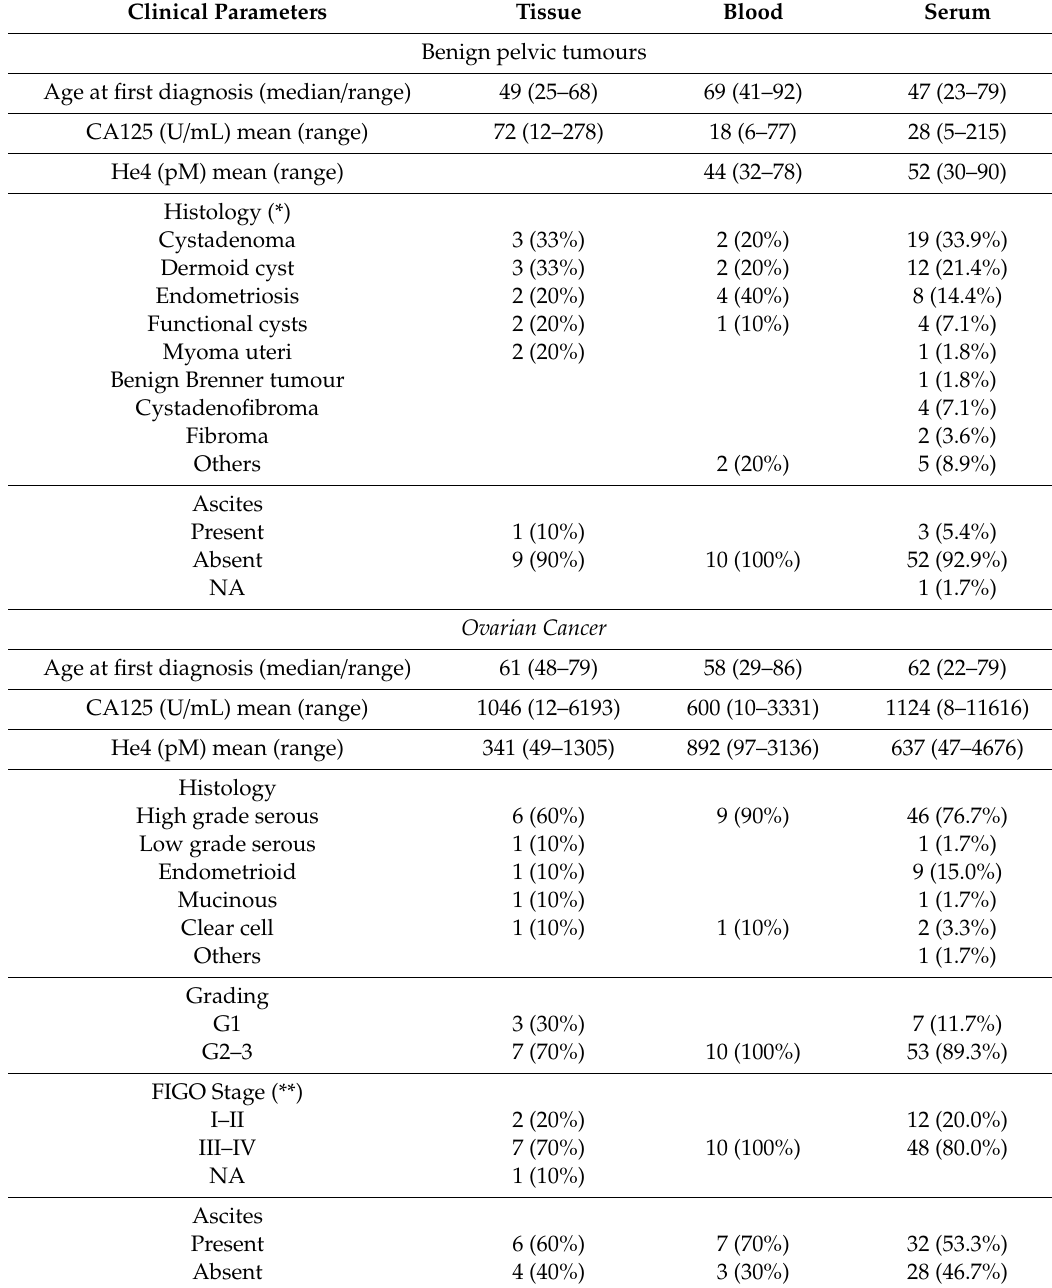
Table 1. Clinico-pathological parameters of the patient